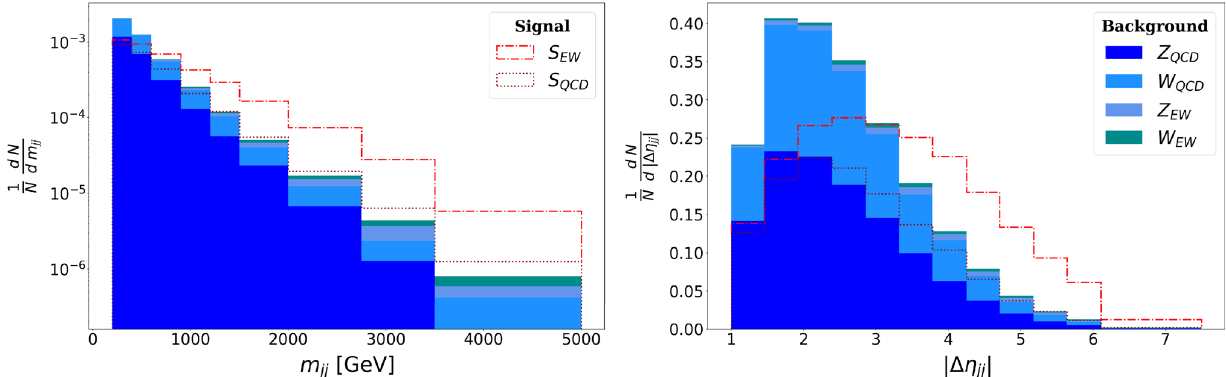
Fig. 5 Distributionof(left) m jj and(right) Δη jj ofeventspassedafter the passing the tighter selection requirement ( met > 250 GeV). The contribution of each channel to its parent class has been weighted by